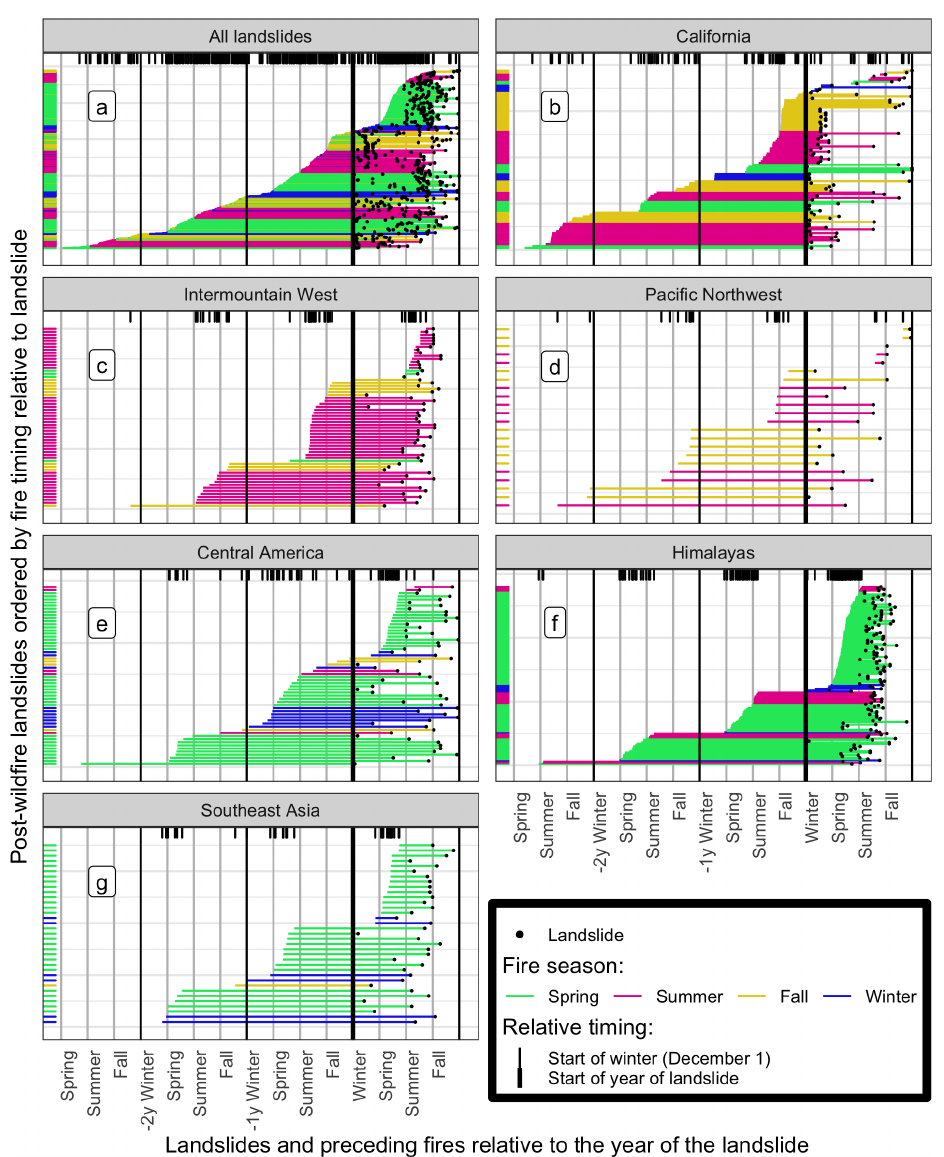
Figure 7. DOY of mass movements, DOY of fires, and the length of time in between fire and mass movement by region. Each horizontal line represents one event, arranged on the y axis in order of the length of the delay between wildfire and mass movement. Black dots on the right show the day of the year the mass movement occurred, and horizontal lines represent the duration of time elapsed in between the fire and the mass movement. Lines are colored by the season of the fire and are ordered by the day of the fire relative to the mass movement. The black lines, or rug, at the top of each panel as well as the colored rug on the left duplicate the day of year of the fires to highlight seasonal